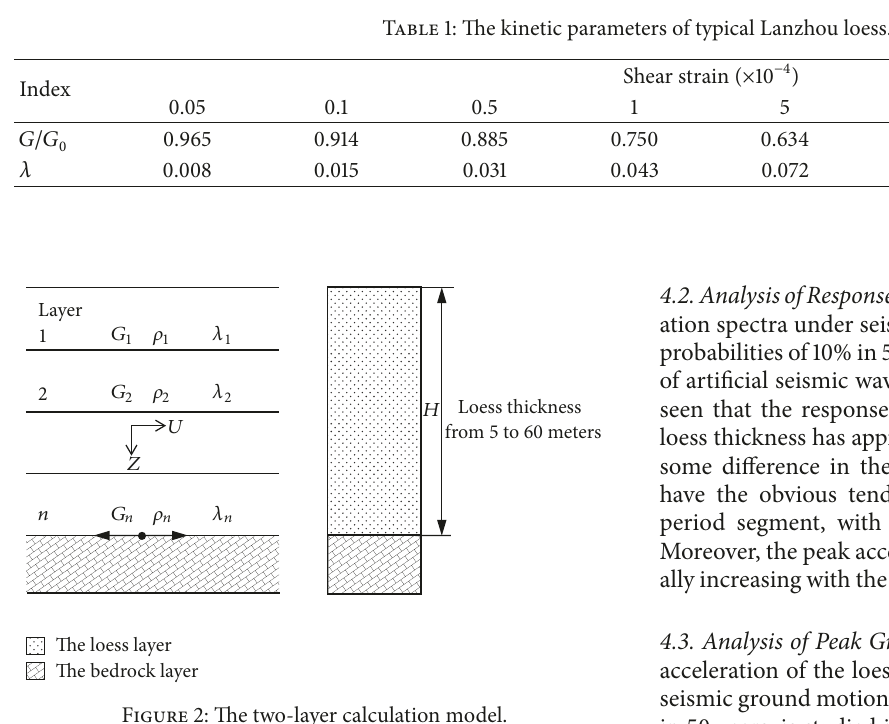
Figure 2: The two-layer calculation